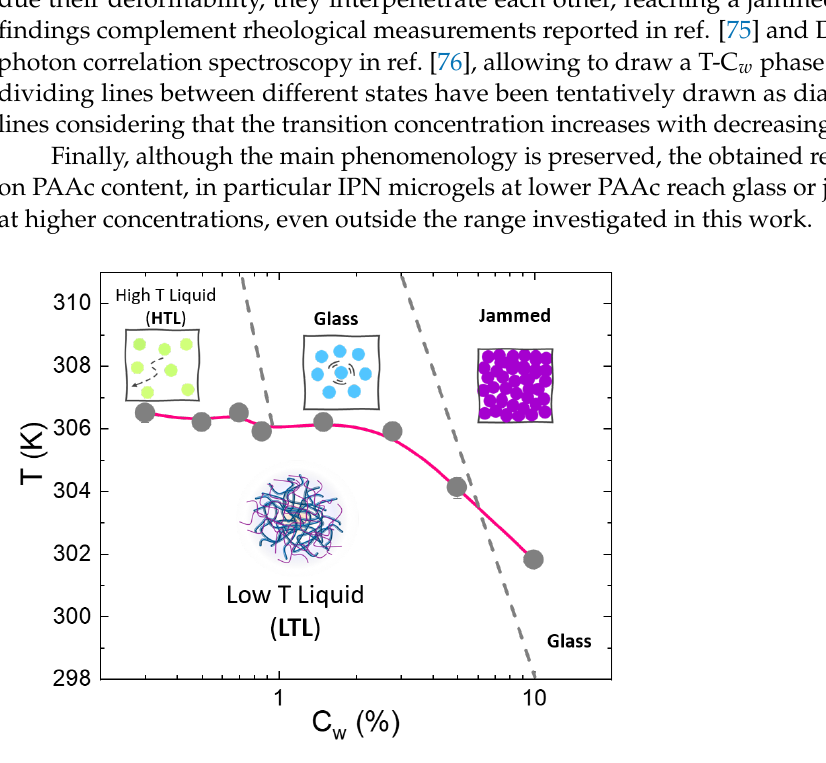
Figure 10. T-C w Phase diagram of IPN microgel suspensions with PAAc content 24.6% and pH 5.5. The onset transition temperatures obtained with DSC measurements at a heating rate r = 10 K/min are plotted as a function of